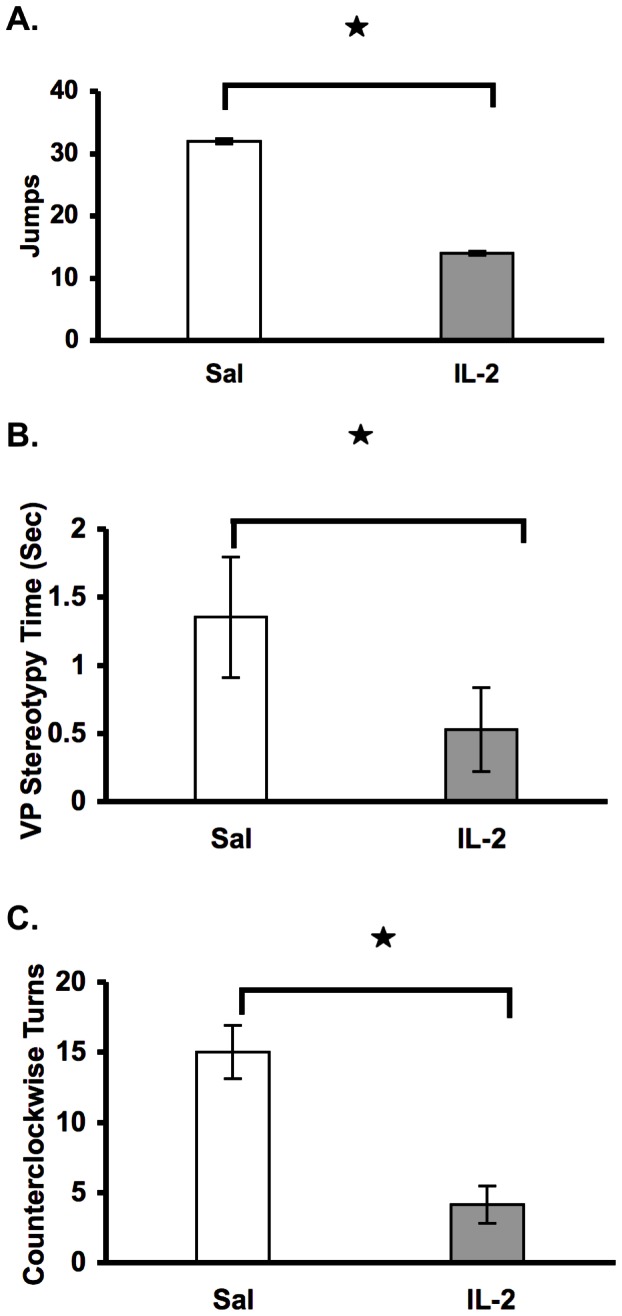
Single injection of IL-2 in periadolescent mice decreases stereotypic behaviors.Mean (± S.E.M.) activity scores (A. Jumps; B. VP STPY Time; C. CCW Turns) following a single injection of saline or IL-2 (0.4 µg/mouse, s.c.). Mice were exposed to the test cage immediately following cytokine administration. *p<0.05.